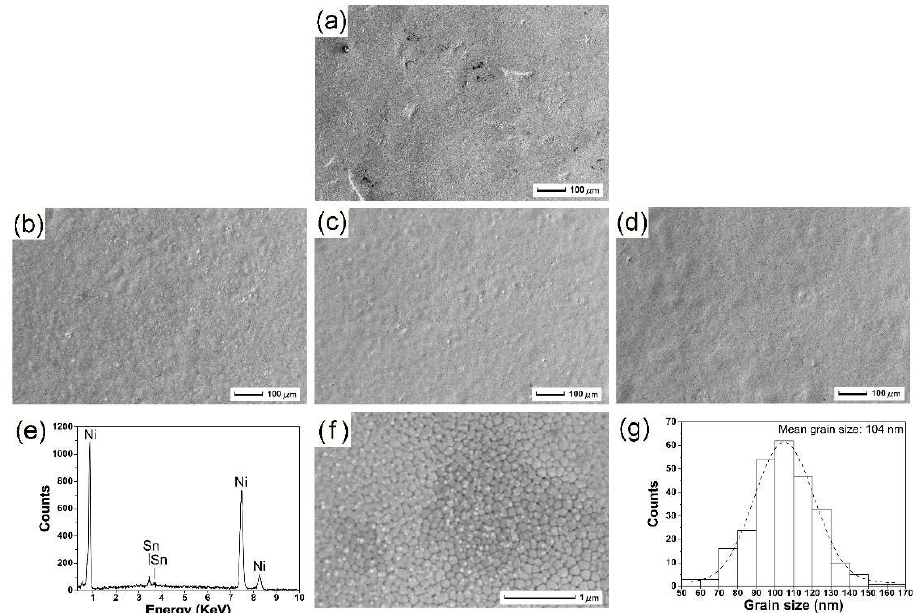
Figure 2. ( a ) SEM morphology of Ni surface after ball milling. Surface morphology of Ni-Sn alloyed samples after ( b ) 10 pulses, ( c ) 20 pulses, and ( d , f ) 30 pulses of HCPEB irradiation. ( e ) EDS analysis